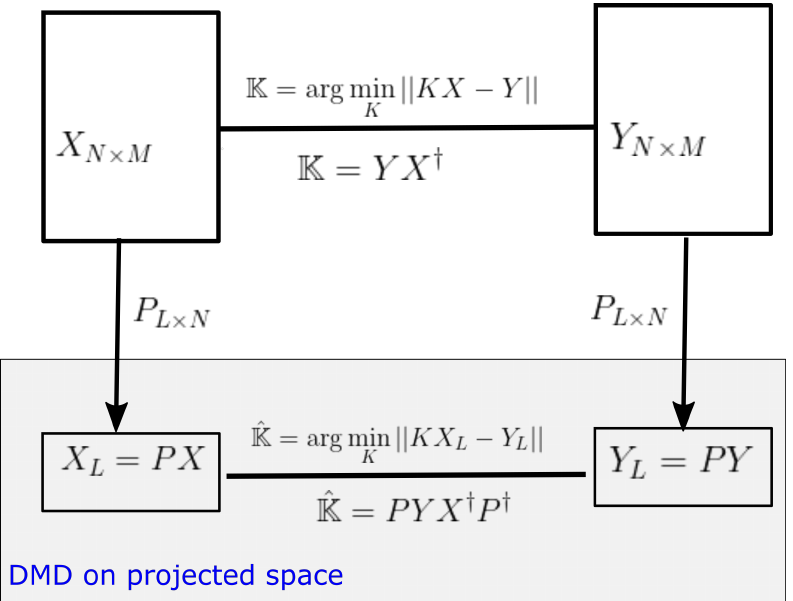
Figure 2. DMD operator on the projected space. This figure shows the relationship between the DMD operator on original space and DMD on projected space. The operator ˆ K on the projected space is defined in Equation (10) and can be calculated by Equation